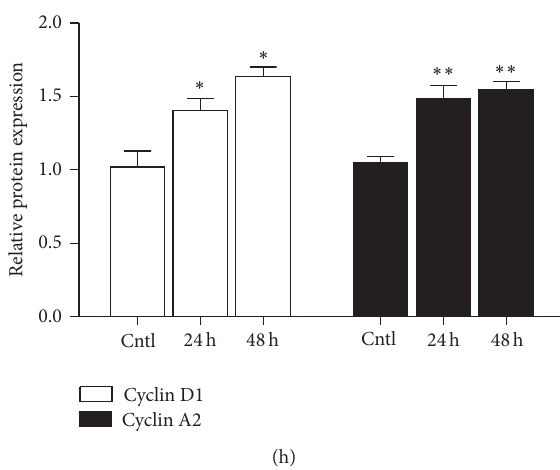
Figure 3: Effects of IS on the expressions of cyclin D1 and cyclin A2 in MCs. After MCs were treated with IS, cyclin D1 (a) and cyclin A2 (b) mRNA levels were elevated in a dose-dependent manner following 24 h treatment. Meanwhile, a time-dependent induction of cyclin D1 and cyclin A2 mRNA expressions was tested (c and d). Protein levels of cyclin D1 and cyclin A2 were also detected using dose- and time-dependent experiments (e–h). All values are means ± SD; 𝑛 = 6 in each group; ∗ 𝑃 < 0.05 versus control and ∗∗ 𝑃 < 0.01 versus control.